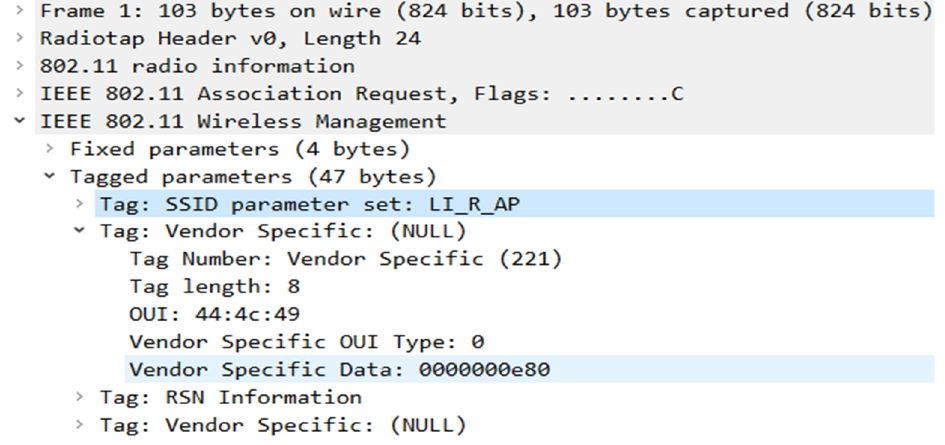
Figure 10. Association request sniffer capture with battery status.